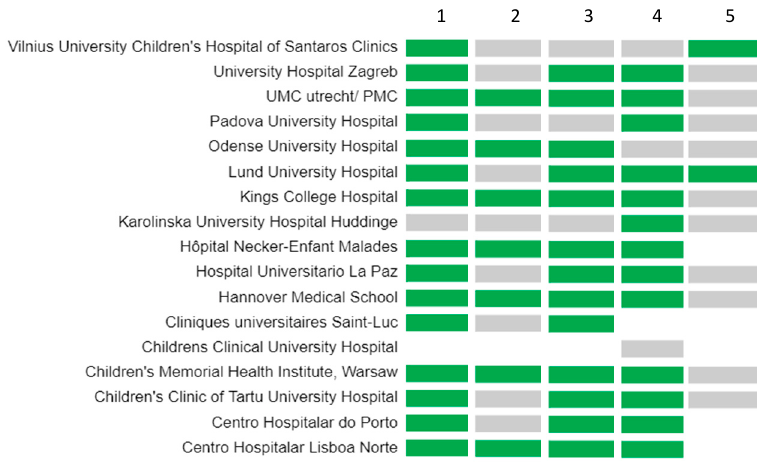
Figure 5. Funding of drugs, pharmaceutical and medical devices in participating centres. From left to right, (1) commercial pharmacy drugs, (2) pharmacy/parapharmacy products, (3) milk or nutritional products (4) medical devices, (5) other drugs. In green, yes; in grey, no; in white, not